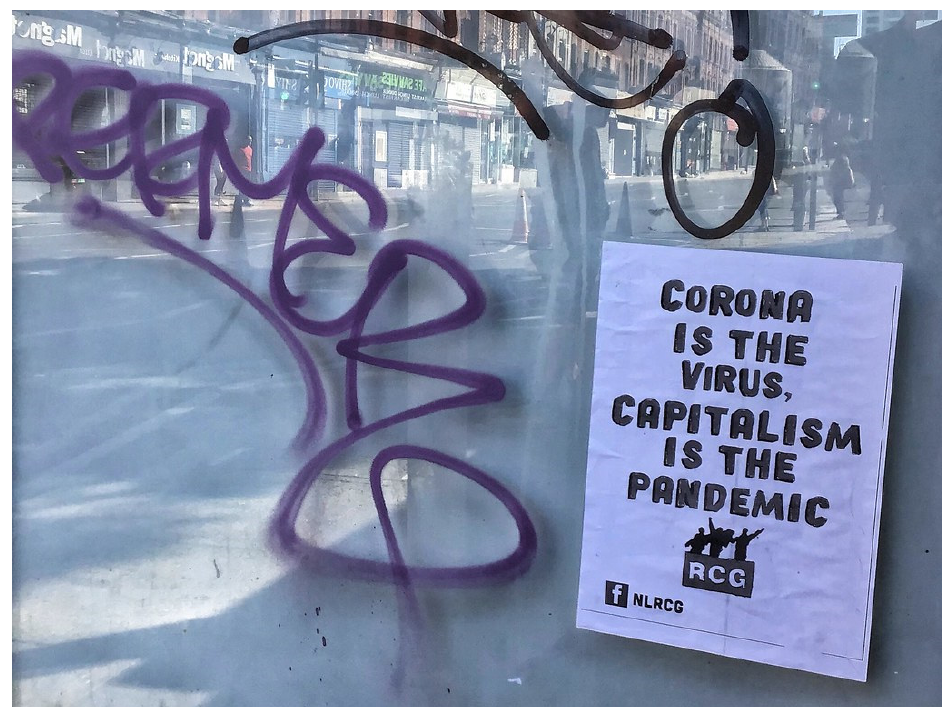
Figure 5. Anti-Capitalist Sign. An anti-Capitalist poster that frames COVID-19 as the virus and Capitalism as the pandemic (Source: https://www.flickr.com/photos/8424687@N08/49953781421/, accessed on 24 August 2021).